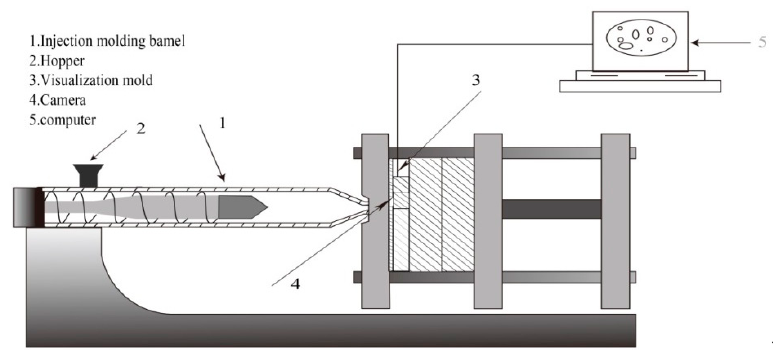
Figure 1. Schematic diagram of the visual injection molding device.